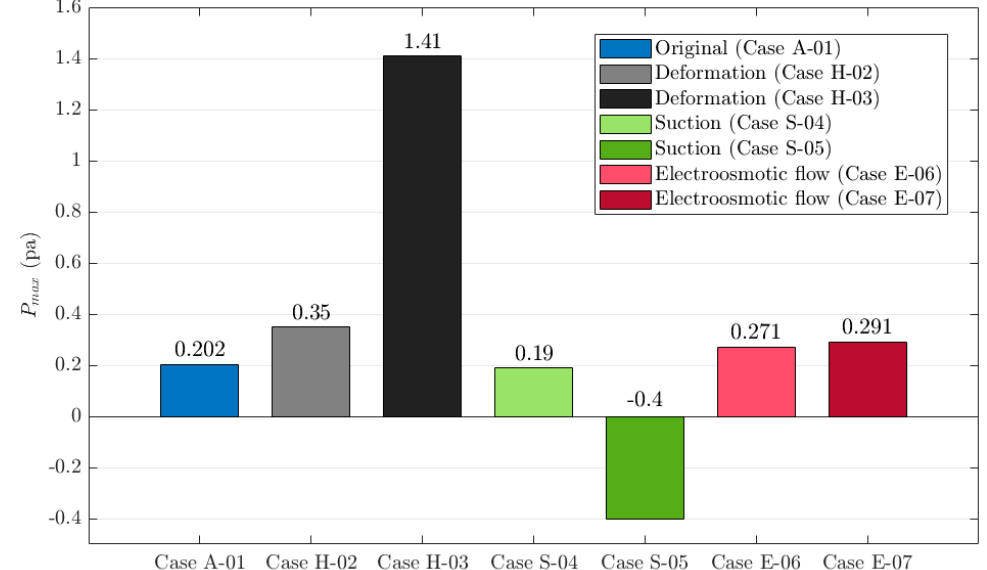
Figure 7. The maximum pressure through the microchamber for the original experimental setup (case A-01), thin chamber (series H-02), the thin chamber with half-height (case H-03), second outlet with zero pressure (case S-04), suction (case S-05), electroosmotic flow (cases E-06 and E-07). For the S series, the pressure at the end of the second outlet is varied from 0 to − 2 pa . For the sake of brevity, only cases S-04 and S-05 are presented in this paper. In Figure 5b, by the end of 50 min, cases S-04 and S-05 show 6% and 10% enhancement in the